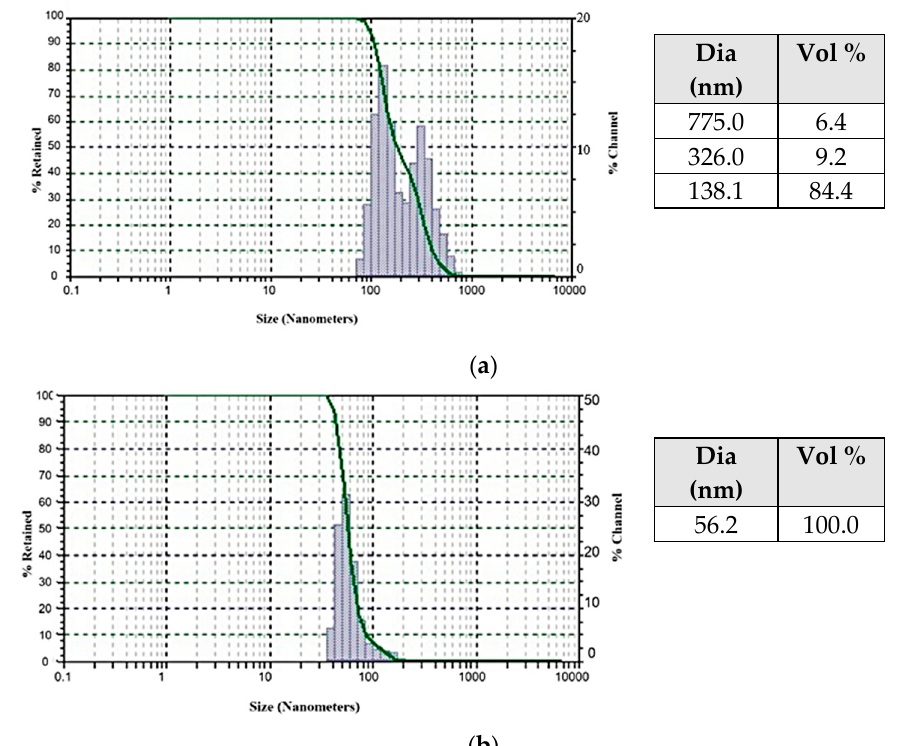
Figure 2. Disperse composition of taxifolin solutions: ( a ) control; ( b ) microstructured (ultrasound 600, 7 min).